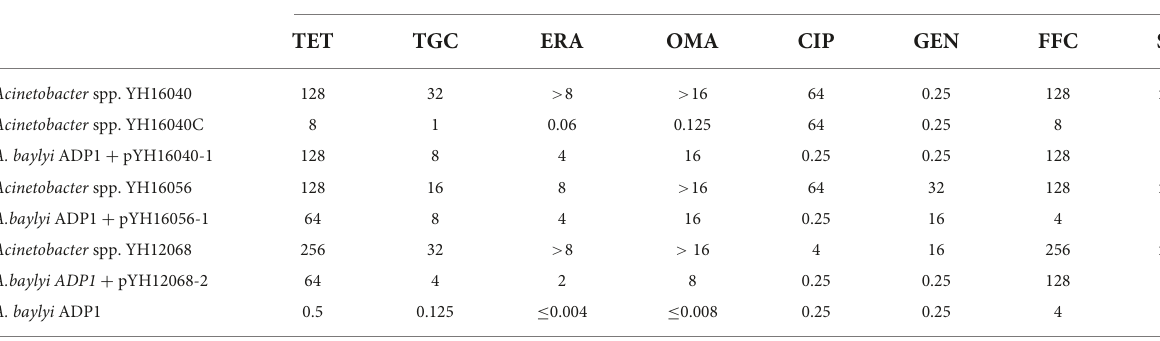
TABLE 2 MICs of tet (X)-positive Acinetobacter spp. isolates, transconjugants, and plasmid-cured strain.